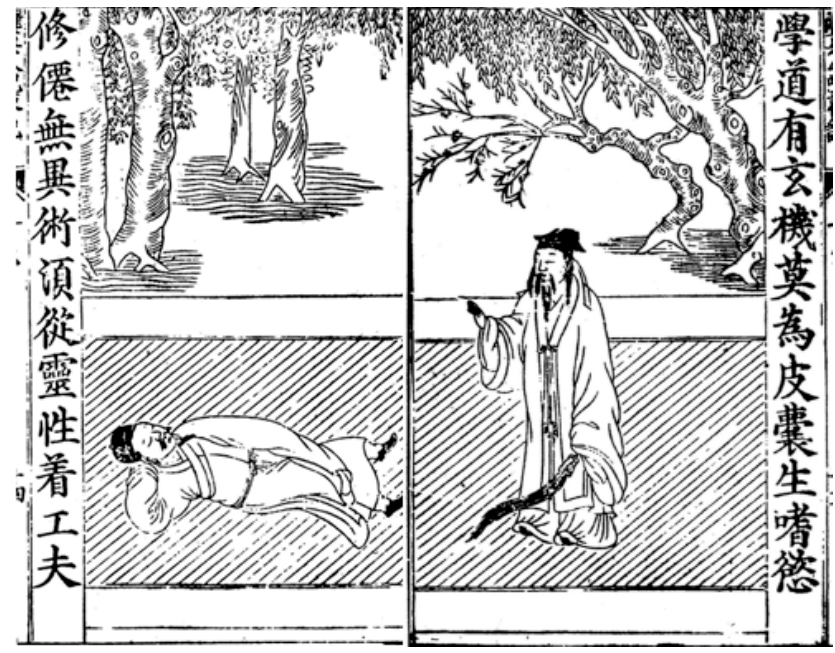
Figure 3. Seeking the Dao in The Enchanted Date , 1603.